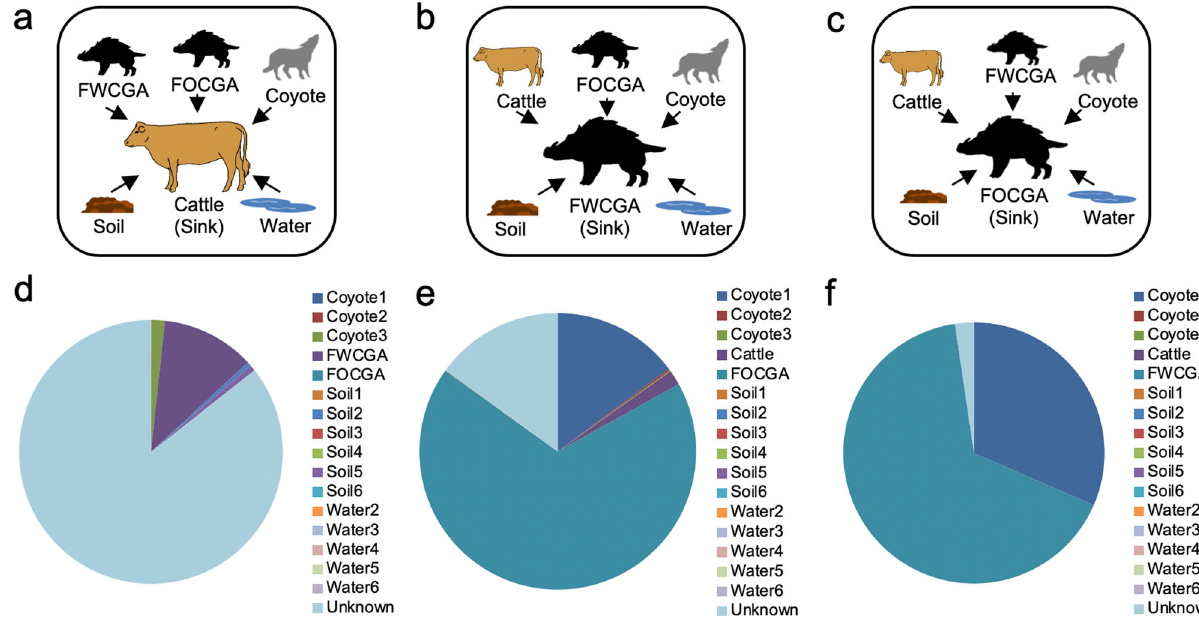
Fig. 5 Source of bacteria between cattle and wildlife. Schematic diagram of SourceTracker analysis when cattle ( a ), FWCGA ( b ), and FOCGA ( c ) are the sinks, respectively. SourceTracker estimates microbiota transmission between sinks and source. Cattle ( d ), FWCGA ( e ), and FOCGA ( f ) are designated as a sink, respectively. Data from cattle, FWCGA, and FOCGA are the means of individual animals; each coyote, soil, and water samples were designated as a single source, respectively. Colors in the pie charts distinguish